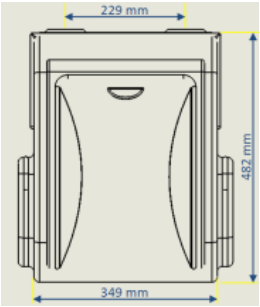
Figure 15. Basic dimensions of the designed